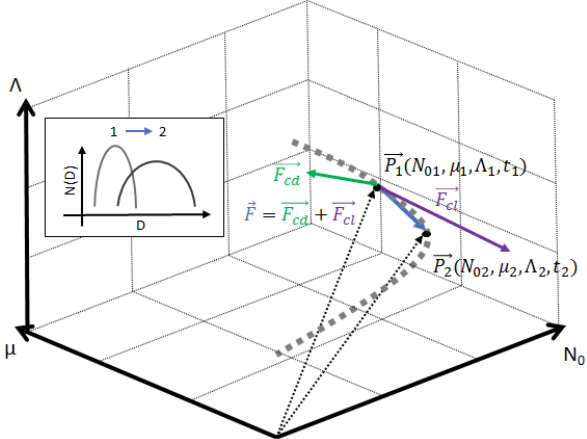
Figure 3. Conceptual drawing of the properties of the gamma phase space in the warm layer of the clouds. The dotted gray line rep- resents one trajectory through the phase space, representing the DSD evolution. P 1 is one DSD that grows by condensation and collision–coalescence to reach P 2 . The displacement represented by the pseudo-force F is decomposed into two components – F cd (condensational pseudo-force) and F cl (collisional pseudo-force). Also shown are the two DSDs representative of points P 1 and P 2